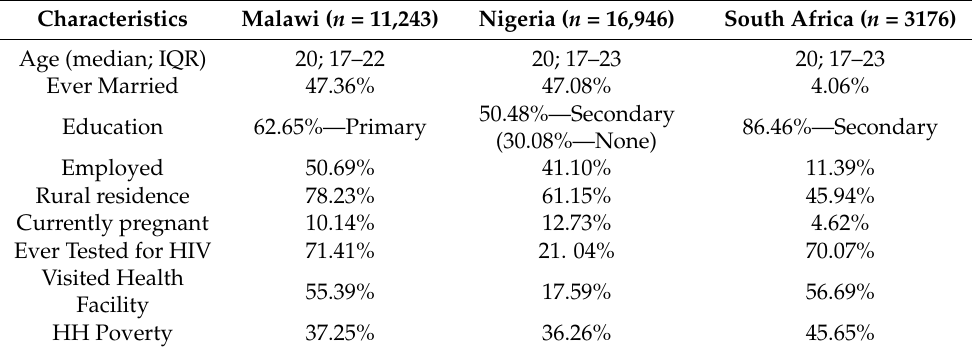
Table 1. The distribution of characteristics of the study participants.